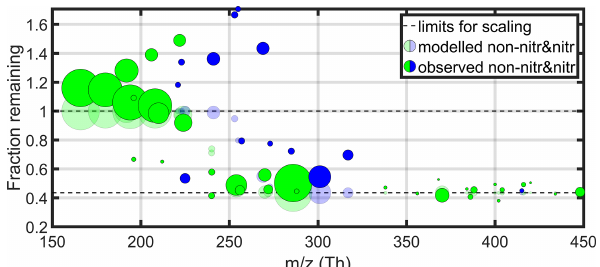
Figure B2. Similar to Fig. 6 except here the Bianchi et al. (2019) model is modified to give a volatility of a hypothet- ical product with four more carbon atoms than in our